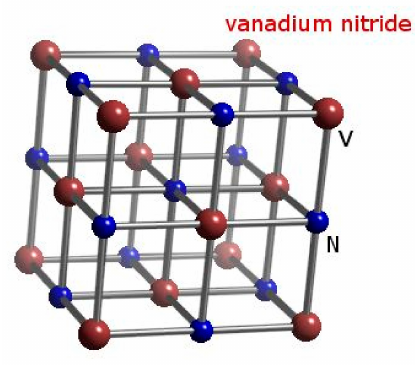
Figure 11. The crystal structure of synthetic VN [62].